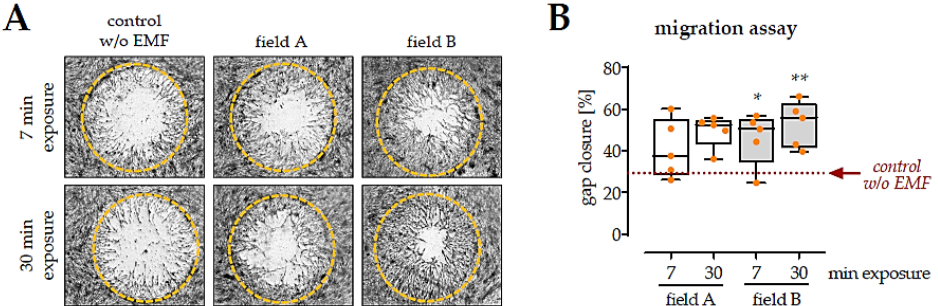
Figure 5. Migration of SCP-1 cells cultured with conditioned medium from macrophages exposed to the ELF-PEMFs. Freshly isolated PBMCs ( n = 5) were stimulated with 200 nM PMA and exposed to the two ELF-PEMF for 7 min or 30 min, respectively. After 24 h, a conditioned medium was collected and added (1:1) to SCP-1 cells in a migration assay. ( A ) Representative images of the migration assay after 48 h. Cells invading the migration zone were visualized by Sulforhodamine B staining. ( B ) The uncovered area in the migration zone was measured with ImageJ software to quantify the migration assay. Data were compared by non-parametric Kruskal–Wallis test, followed by Dunn’s multiple comparison test: * p < 0.05 and ** p < 0.01 as compared to control conditions (without ELF-PEMF